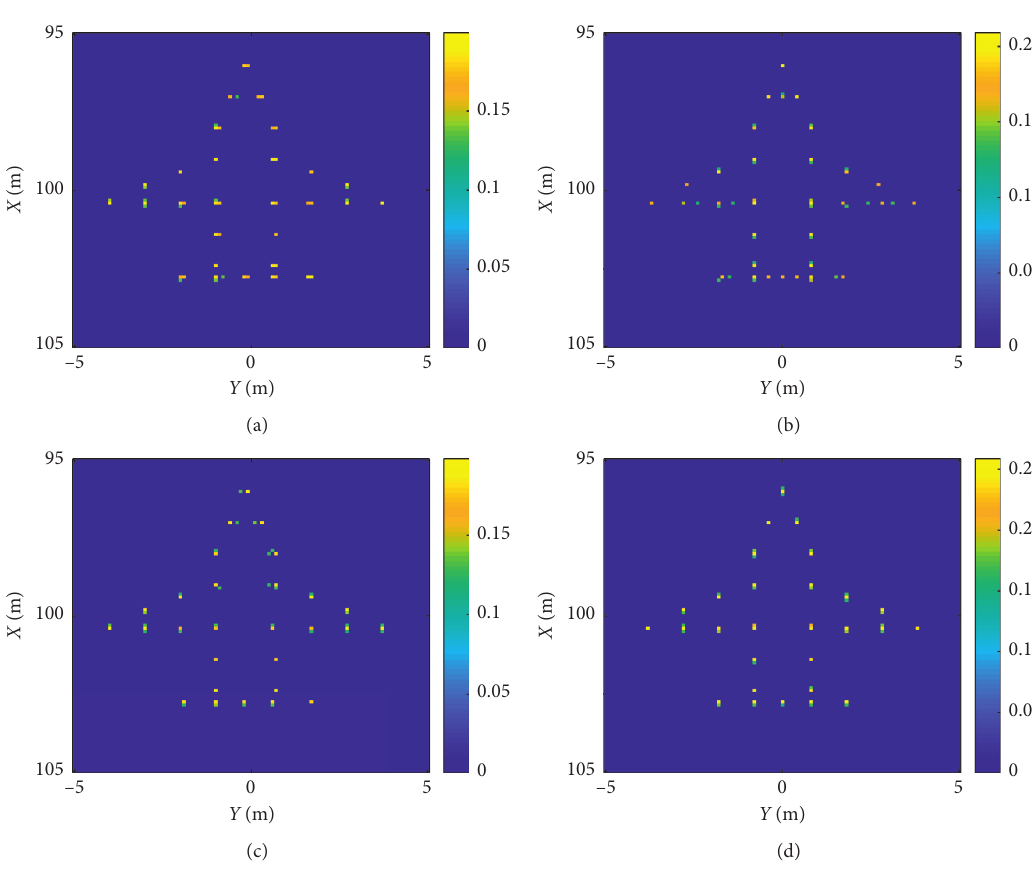
Figure 10: Comparison of OMP reconstruction results of four methods in –5dB Gaussian white noise environment. (a) The result of point- by-point method. (b) The result of subaperture method. (c) The result of phase error correction method. (d) The result of the proposed method.